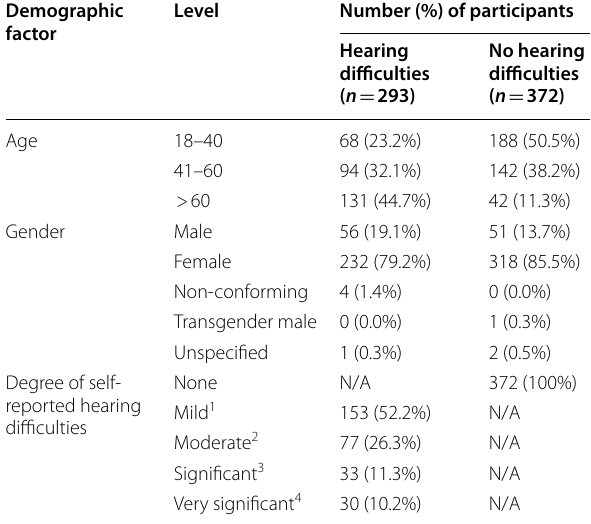
Table 1 Summary of participant characteristics for the 665 participants divided into groups with and without self-reported pre-existing hearing